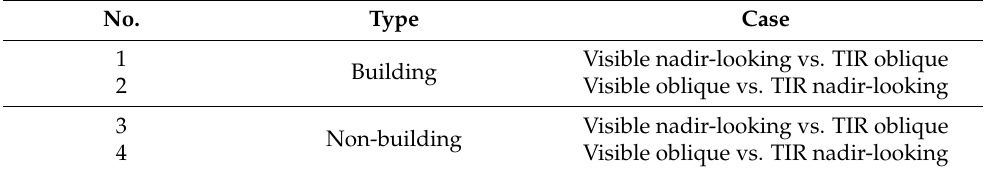
Table 3. Category of experimental images.